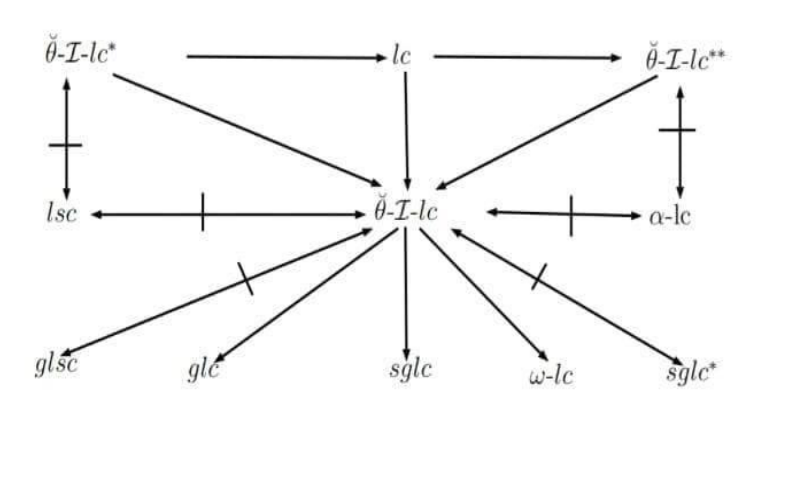
Figure 1: Relations between some of generalized closed